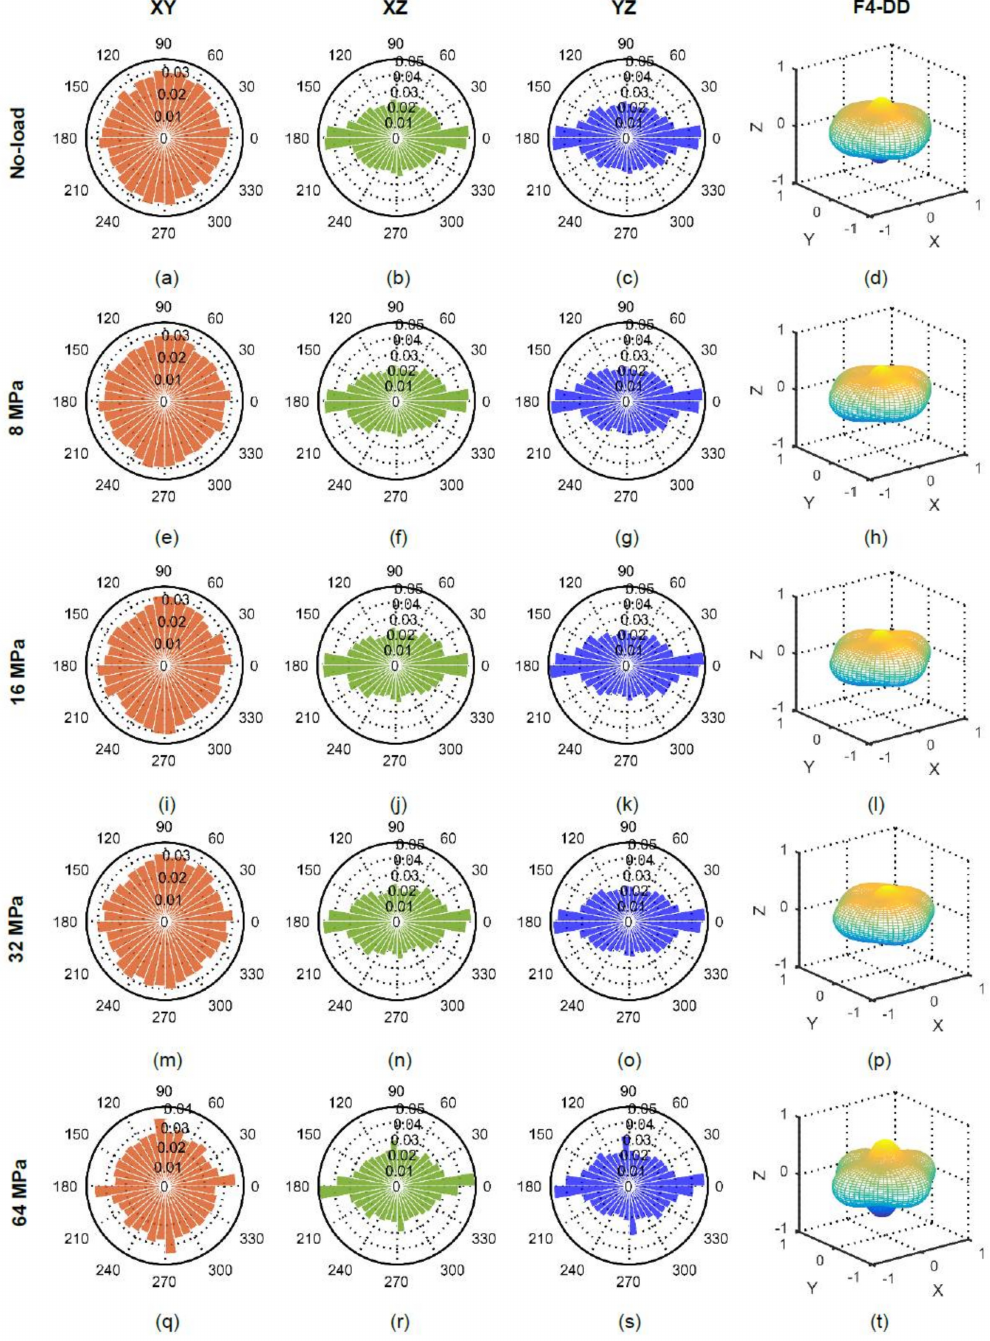
Figure 12. Particle orientations at different vertical stresses for RBS particles (F4-DD: 4th order approximation of distribution